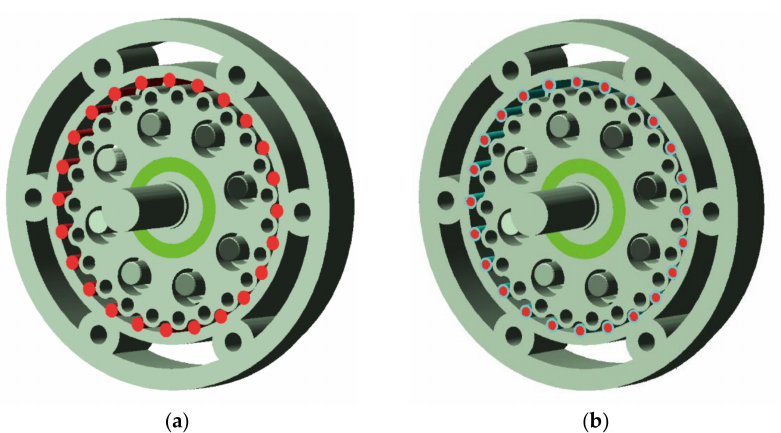
Figure 16. Two structural simulation models. ( a ) Construction without pin tooth sleeve (red indicates pin teeth). ( b ) Construction with pin tooth sleeve (cyan indicates sleeve).